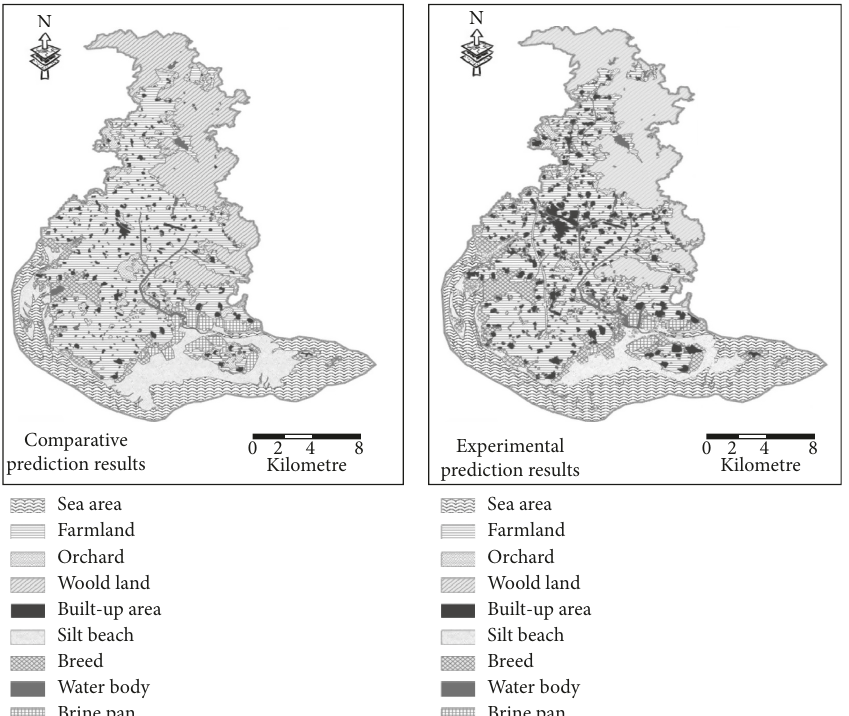
Figure 6: Legend of wild plant pattern prediction results before and after the application of the improved clustering